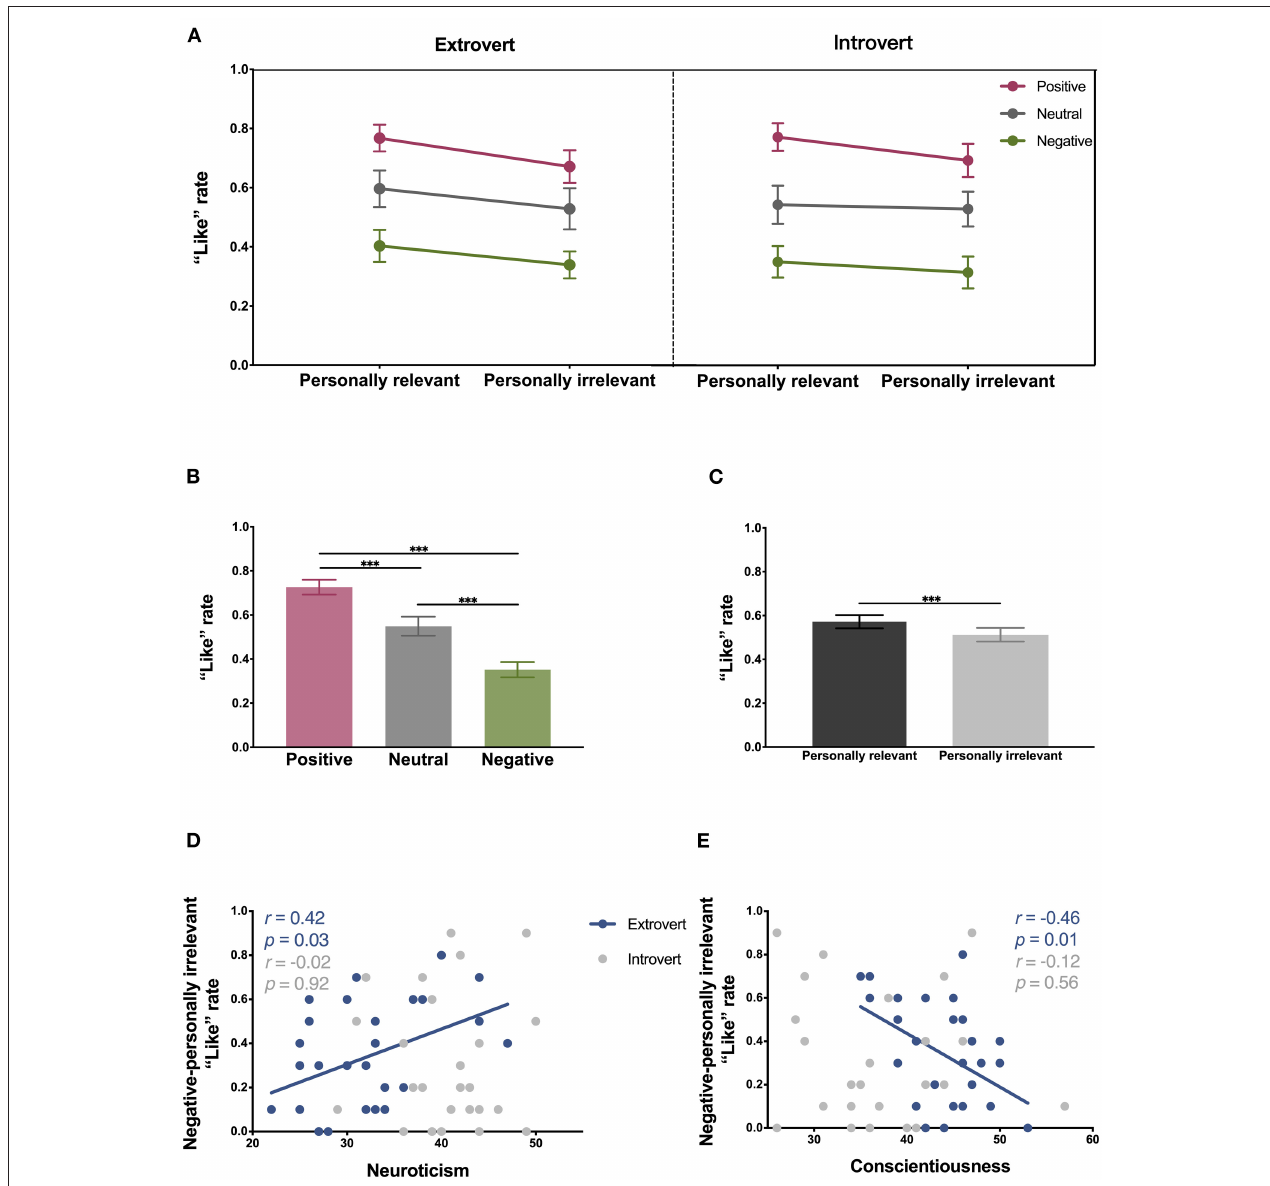
FIGURE 2 | “Like” rates and their correlation with personality traits. (A) “Like” rates for the extrovert and introvert groups for the six conditions examined: positive-personally relevant, neutral-personally relevant, negative-personally relevant, positive-personally irrelevant, neutral-personally irrelevant, and negative-personally irrelevant. Three-factor ANOVA results demonstrate that the main effect of emotional valence ( F 2,108 = 46.22, p < 0.001, partial η 2 = 0.46) and the main effect of personal relevance ( F 1,54 = 19.54, p < 0.001, partial η 2 = 0.27) were significant. (B) The main effect of emotional valence on “Like” rate (positive vs. neutral: Cohen’s d = 0.63, positive vs. negative: Cohen’s d = 1.49, neutral vs. negative: Cohen’s d = 0.69). (C) The main effect of personal relevance on “Like” rate (relevance vs. irrelevance: Cohen’s d = 0.26). (D) Correlations between “Like” rates and neuroticism scores for the negative-personally irrelevant condition. (E) Correlations between “Like” rates and conscientiousness scores for the negative-personally irrelevant condition. Error bars indicate standard errors. *** p < 0.001. 1.11, p = 0.332, partial η main effect of extraversion, nor the interaction effect, were significant (main effect of extraversion: F 1,54 = 0.09, p = 0.769, partial η 2 = 0.00; interaction effect of extraversion × emotional valence: F 2,108 = 0.24, p = 0.786, partial η 2 = 0.00; interaction effect of extraversion × personal relevance: F 1,54 = 1.53, p = 0.221, partial η 2 = 0.03; interaction effect of emotional valence × personal relevance: F 2,108 =